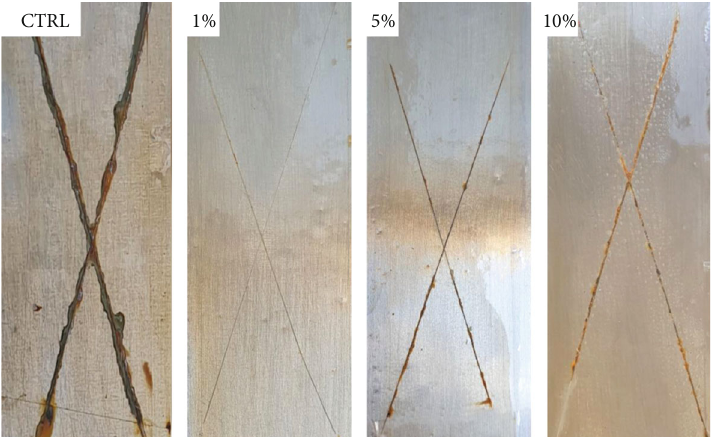
Figure 12: Samples after 72 hours of exposure in the salt spray chamber. The control coating and the coatings containing 1, 5, and 10wt%